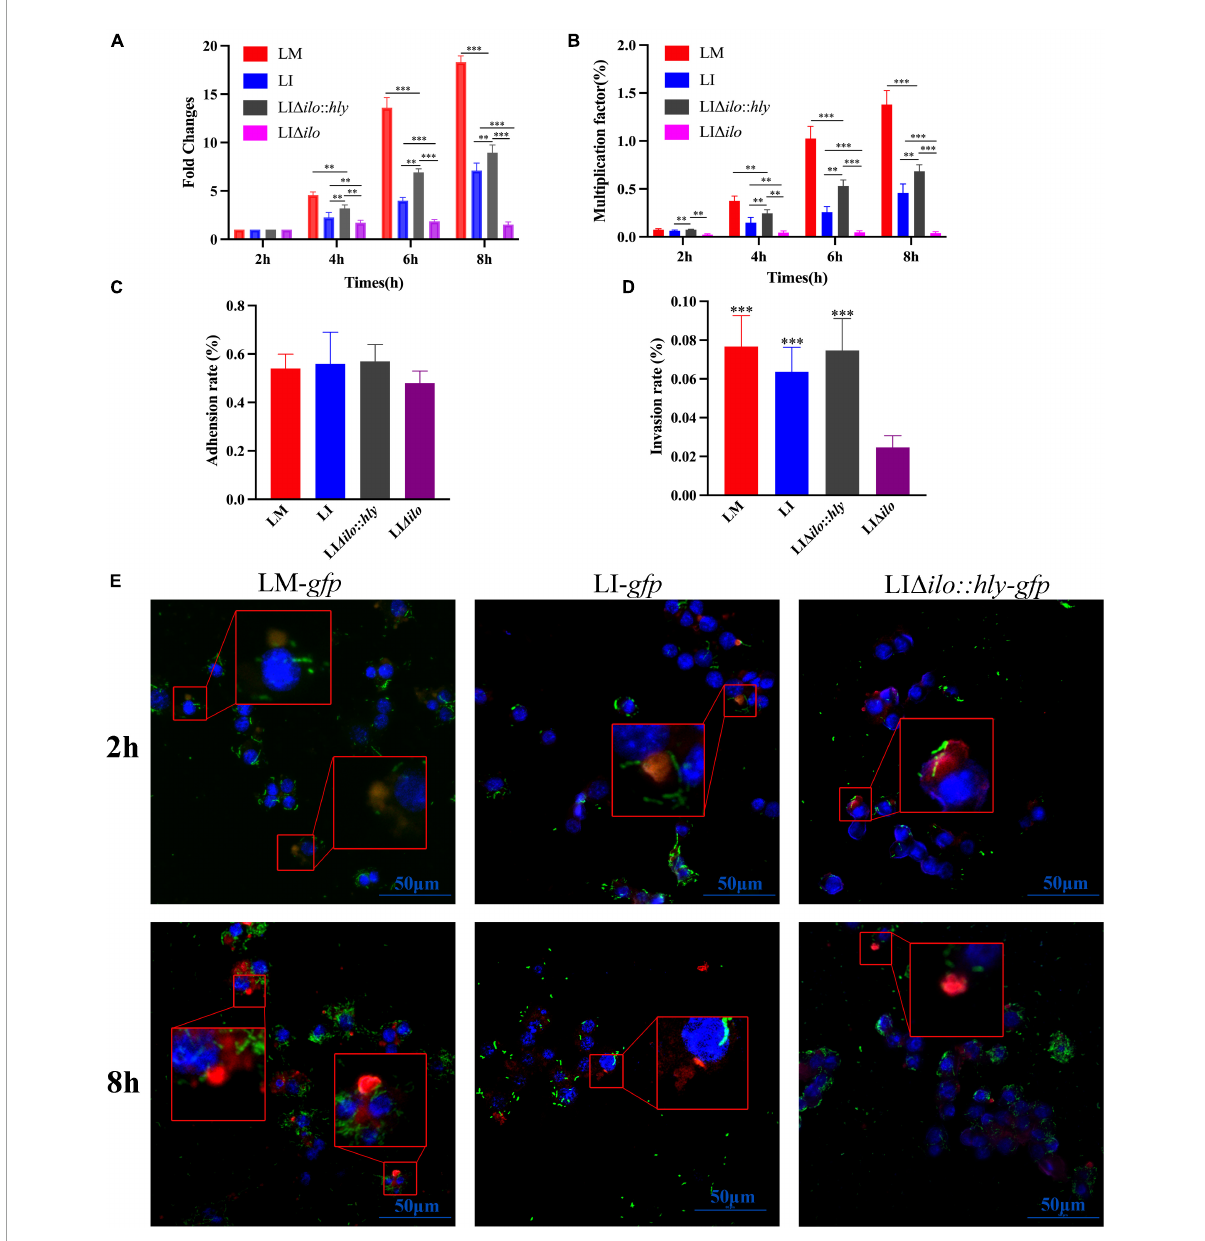
FIGURE3 Intracellular proliferation, cell adhesion and invasion and lysosome escape ability. The fold changes (A) and multiplication factor (B) of each strain in mouse macrophage RAW 264.7, ∗∗ P < 0.01, ∗∗∗ P < 0.001; The adhesion (C) and invasion (D) ability of each strain to Hepa1-6 cells, the experiments were performed with biological triplicates, and results are expressed as means ± SEM per group, ∗∗∗ P < 0.001, vs. LI (cid:49) ilo . Experiments were carried out at least three times. The proliferation of each strain at 2 and 8 h post infection in RAW 264.7 observed by Laser scanning confocal microscopy (LSCM) (E) , blue, green, and red were labeled the nucleus, bacteria and lysosomes respectively. The lysosomes in Figure 3D were orange or pink at 2 h (bacteria have not escaped), but were red at 8 h (bacteria had escaped). The scale bar in Figure 3D is 50 µ